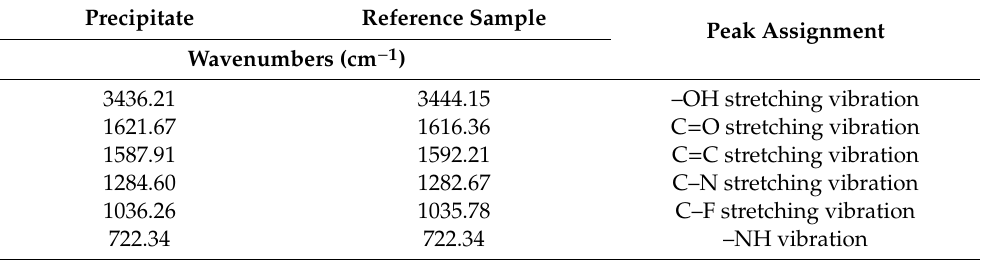
Table 4. Characteristic bands of precipitate and reference sample in FT-IR spectra.